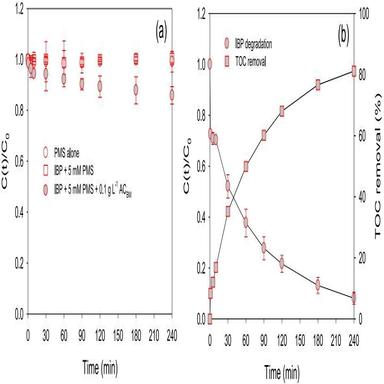
(a) Consumption of PMS during IBP degradation in aqueous solution, (b) % Removal of TOC on IBP degradation in the ACBM/PMS system.